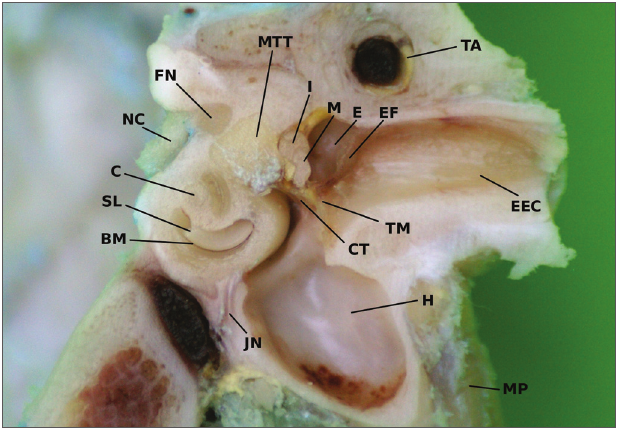
Figura 2. Seção transversal congelada do osso temporal de uma ove- lha (ouvido esquerdo), mostrando o ouvido médio, o conduto auditivo externo (EEC) e o ouvido interno em uma incidência frontal. Os giros da cóclea (C) são bem visíveis com a lâmina espiral óssea (SL) e a membrana basilar (BM) dentro. Acima do músculo tensor do tímpano (MTT) podemos identificar seu curso até o cabo do martelo. O nervo coclear (CN) pode ser identificado dentro do canal do ouvido interno com relação anatômica com o nervo facial (FN). O conduto auditivo externo é aberto cortando-se a membrana timpânica (TM) e a dobra epitimpânica (EF). No ouvido médio, pode-se identificar o corpo da bigorna (I) e partes do martelo (M). Caudalmente está a grande bula hipotimpânica (H). MP = Plano mastoideo, TA = artéria temporal, E = epitímpano, JN = nervo de Jacobson.